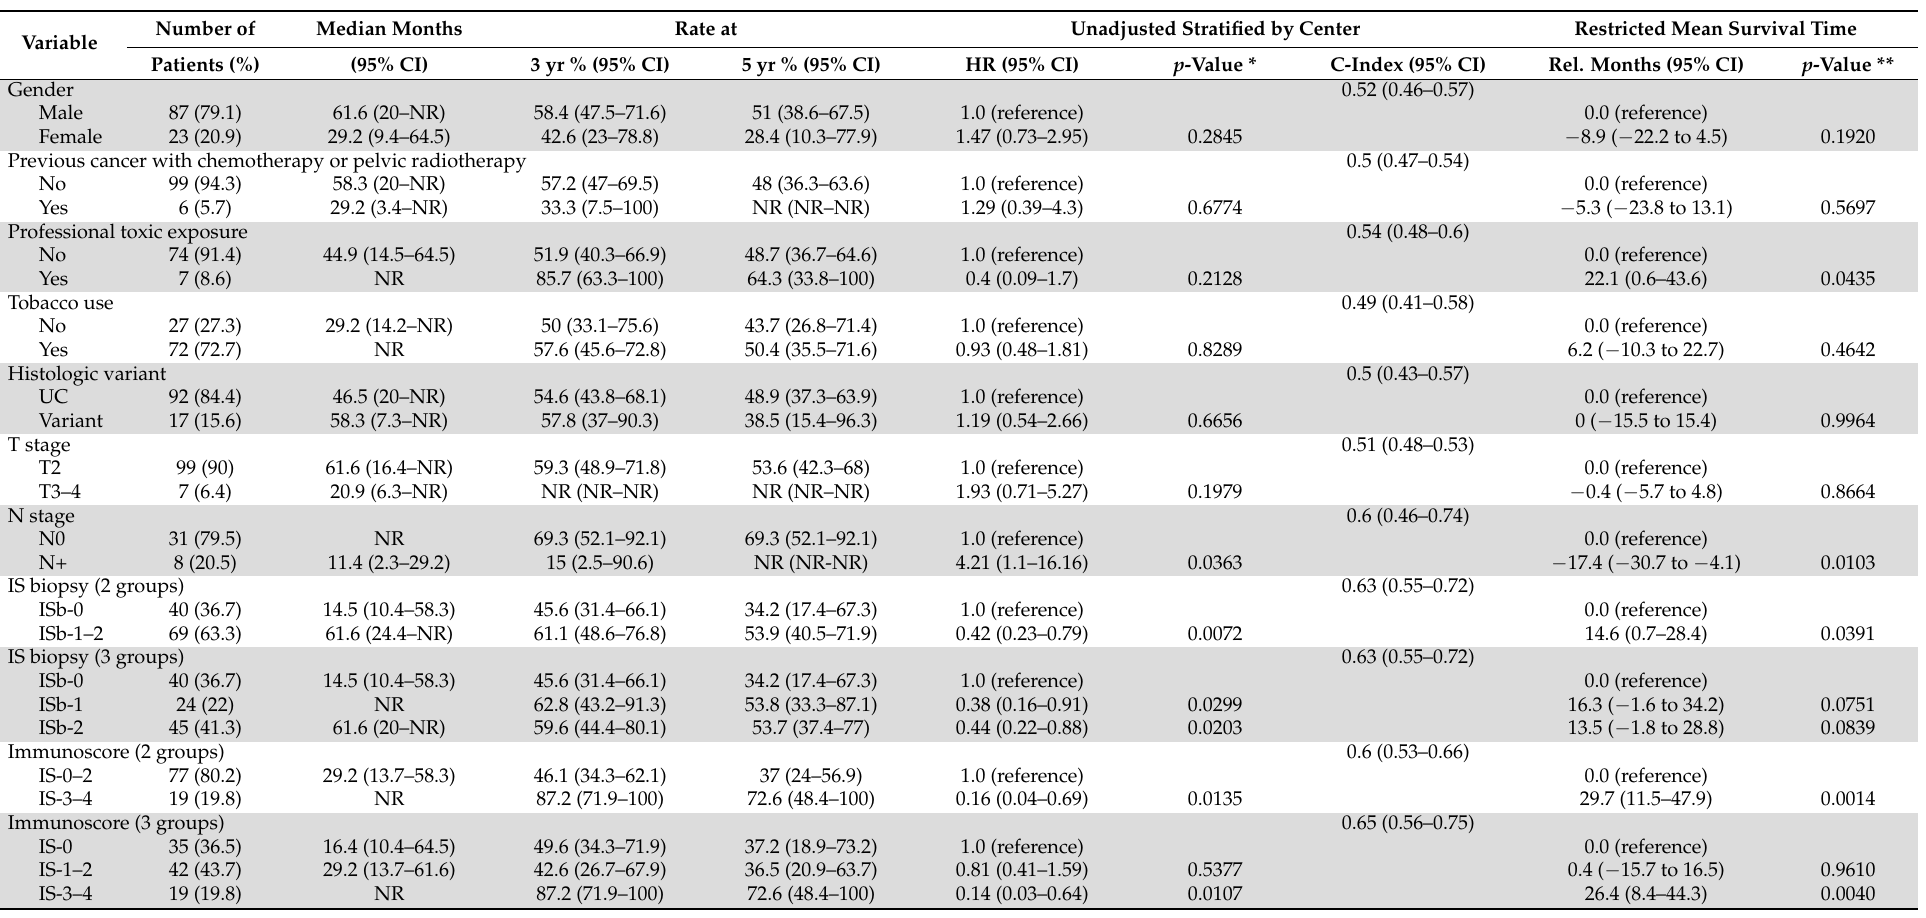
Table 3. Bivariable analysis for the clinical parameters for the time to